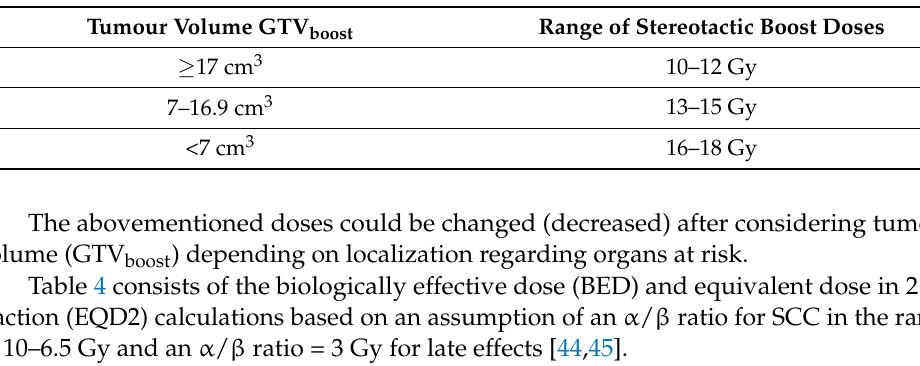
Table 3. Range of boost doses depending on tumour volume.